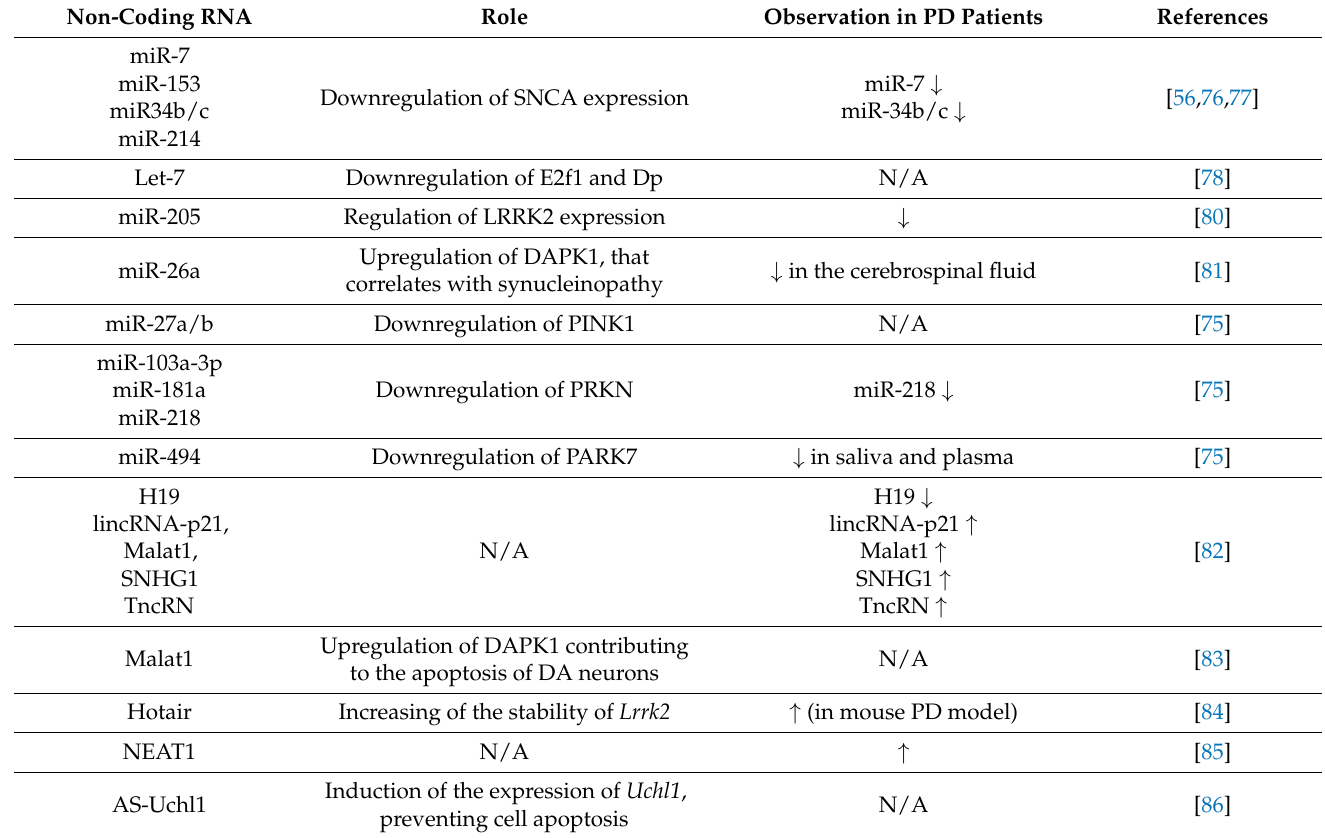
Table 4. Schematic overview of miRNAs and lncRNAs involved in the pathogenesis of PD. Non-Coding RNA Role Observation in PD